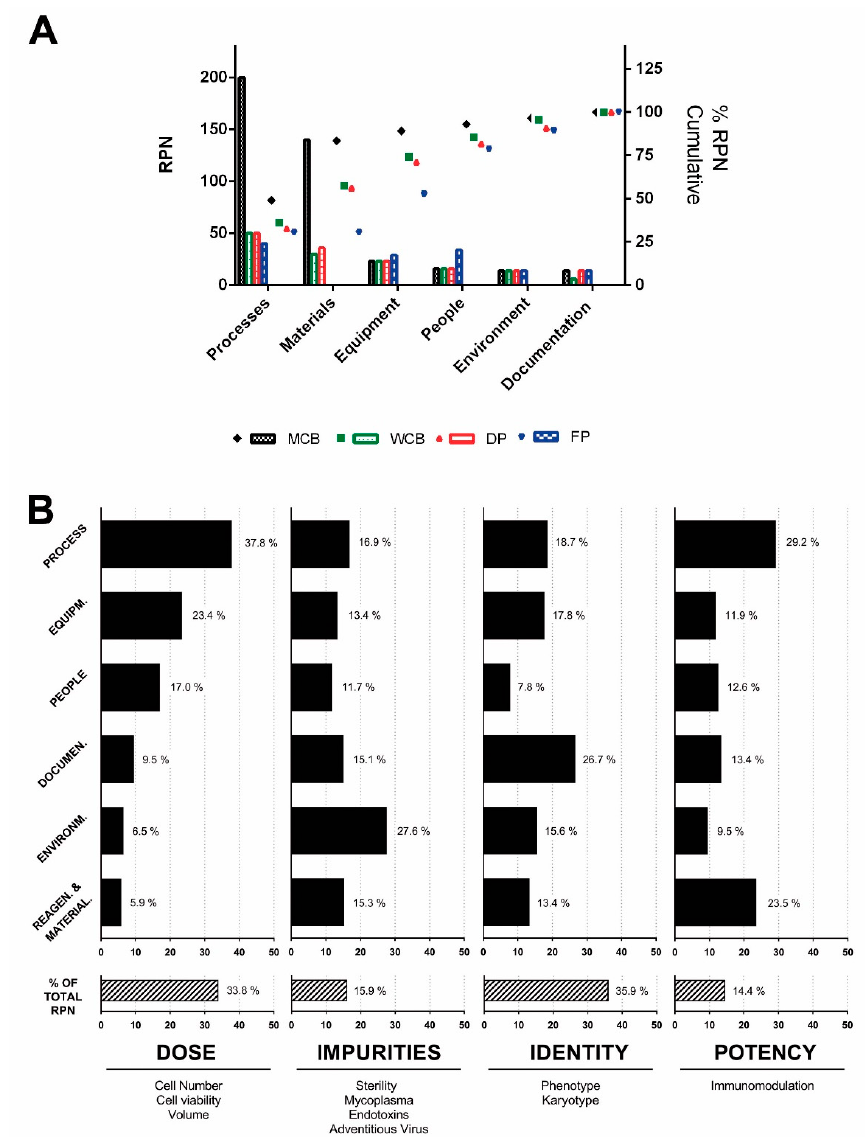
Figure 4. Risk analysis. ( A ) A Pareto chart was generated and plotted according to the classification and the failure group. ( B ) Graphical representation of the impact of risks from each failure group on critical quality attributes. The graphical view of the risk analyses for each of the failure groups